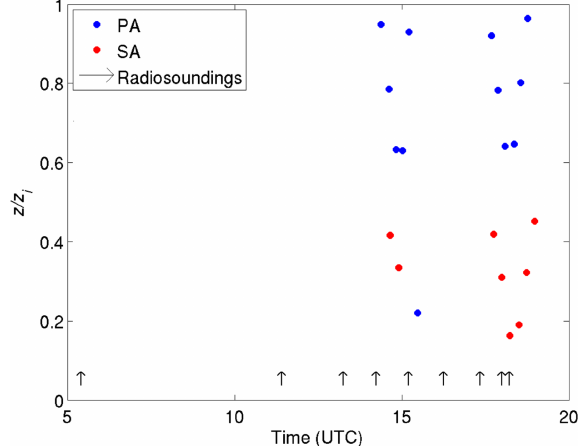
Figure 1. Normalized altitude z/z i (where z i is the PBL depth) of the legs flown by the two aircraft on 20 June 2011 (Piper Aztec in blue, Sky Arrow in red) and launching times of the radiosoundings (black